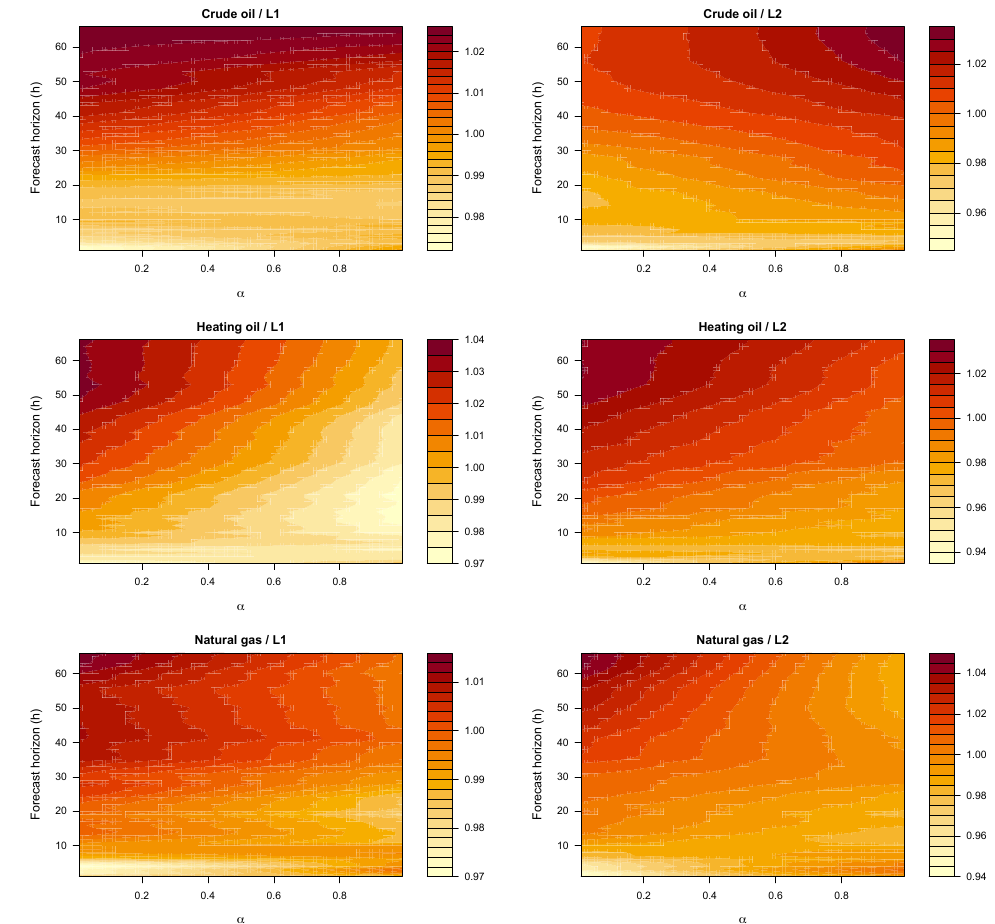
Figure 4. Loss ratios for longer forecast horizons. The parameter α captures the (as-)symmetry of the loss function. The loss function is of the L = ( α + ( 1 − 2 α ) I fe < 0 ) | fe | p , where fe denotes the forecast error and the parameter p governs whether the loss function is of the L1 (quasi-linear function that depends on the absolute forecast error) or L2 (quadratic loss) type. The nominator of the loss ratio is given by the sum of the loss from the out-of-sample forecast errors as computed by means of the HAR-RV benchmark model. The denominator of the loss ratio is given by the sum of the loss from the out-of-sample forecast errors as computed by means of the HAR-RV model extended to include all climate-risk factors. A ratio exceeding unity indicates that the extended model has a better out-of-sample forecasting performance than the benchmark model, given the (as-)symmetry parameter, α . It should be noted that the representation of the numerical values of the loss ratio by colors is not identical across the three panels of this